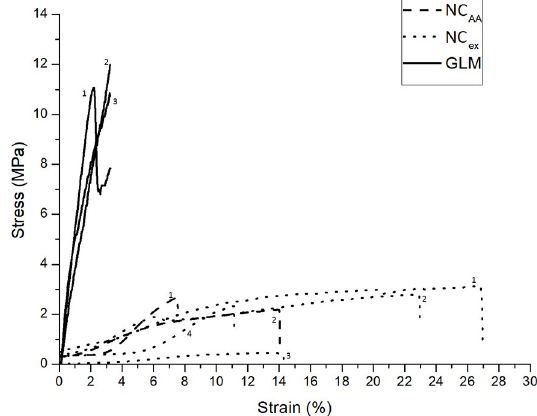
Figure 4. Mechanical behavior of cast films of pure galactomannan (GLM) and the nanocomposites containing nanoparticles with encapsulated ascorbic acid (NC ) and acerola extract rich in AA vitamin C (NC ex ). ex